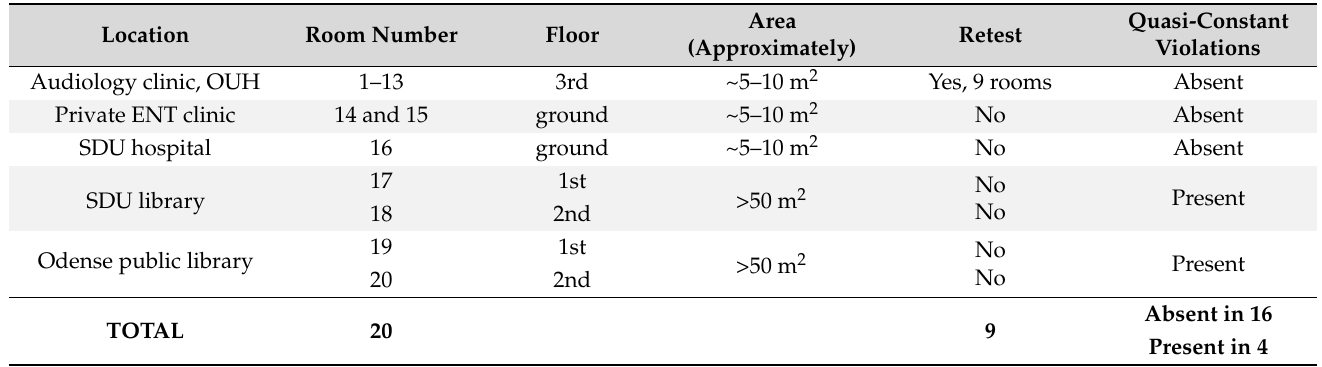
Table 1. Room demographic data and presence or absence of quasi-constant